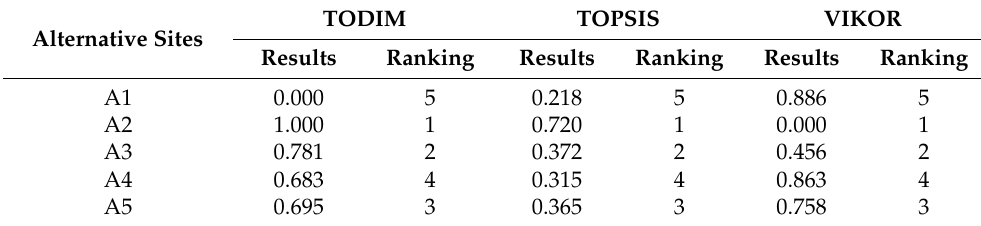
Table 5. Comparative analysis